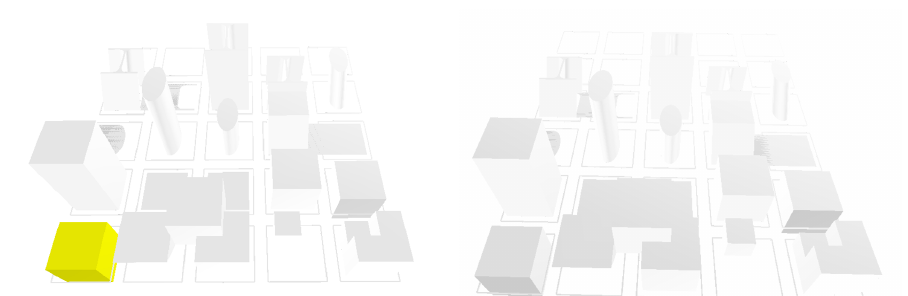
Figure 3. Case B: IFC geometries, both in IFC v.2x3 and v.4, converted to bldg:buildings , visualized in azul. It is possible to notice that, for some reason, these are inverted with respect to their original distribution.